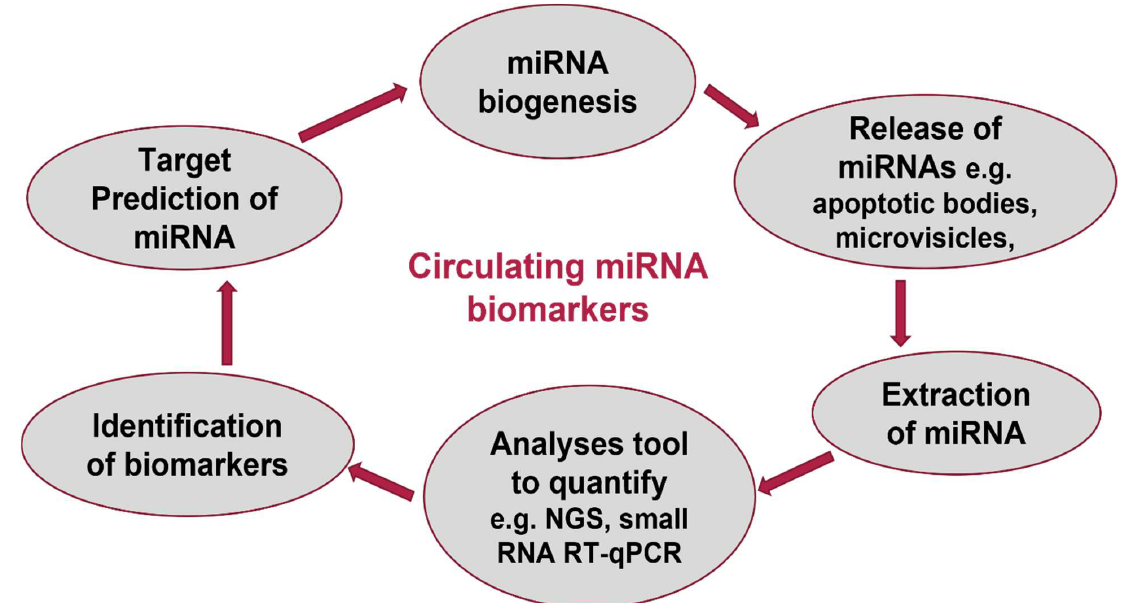
Figure 2. Circulating miRNAs as biomarkers.